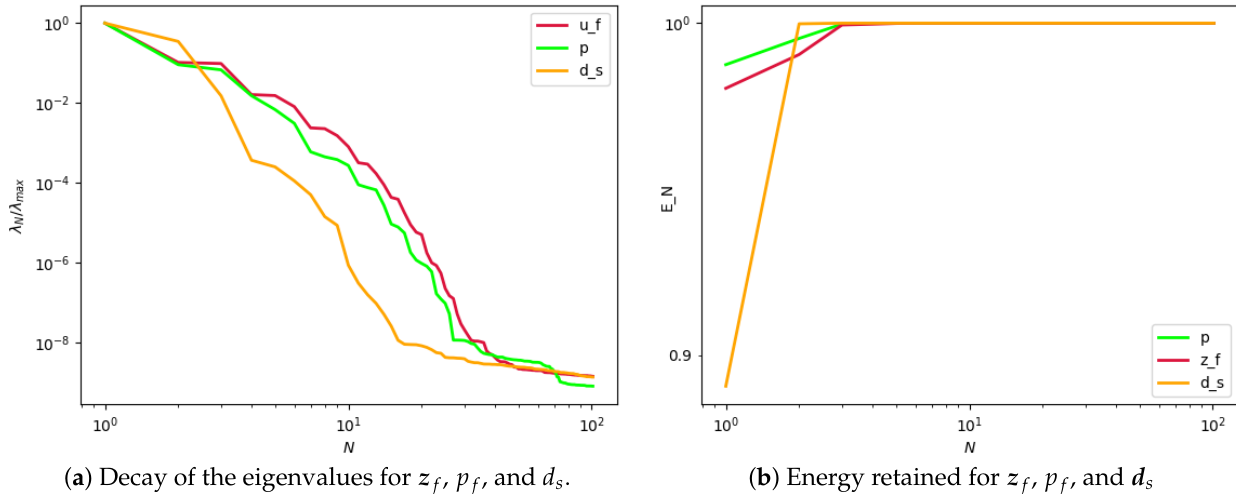
Figure 14. The outcomes of the partitioned POD: eigenvalue decay ( a ) and energy retained ( b ) for the first 100